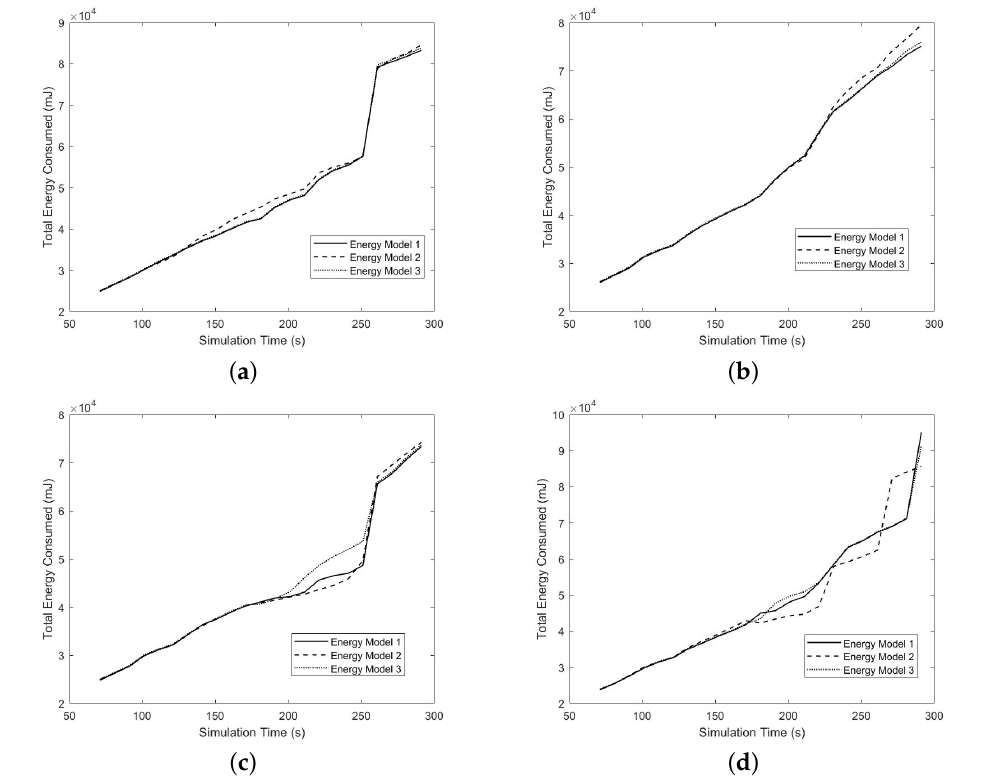
Figure 12. Evaluation of the different Scenarios. ( a ) Energy Consumption of Scenario 1, ( b ) Energy Consumption of Scenario 2, ( c ) Energy Consumption of Scenario 3A, ( d ) Energy Consumption of Scenario